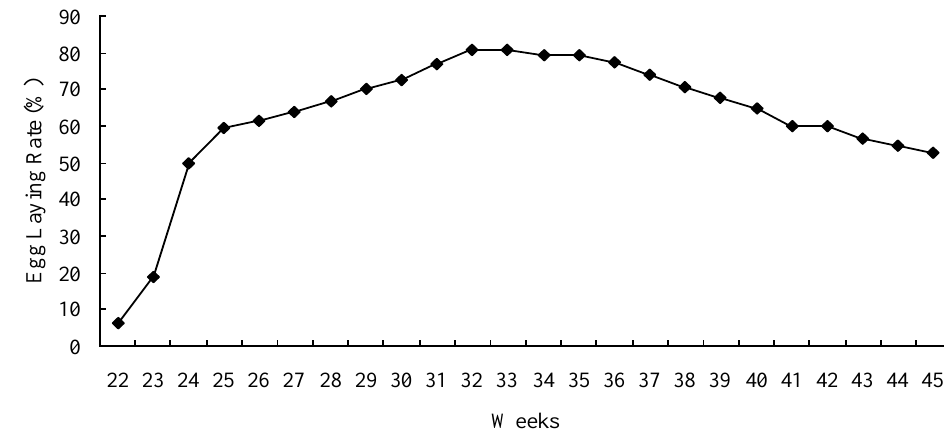
Figure 1. The egg laying rate per week from 22 wk to 45 wk in experimental